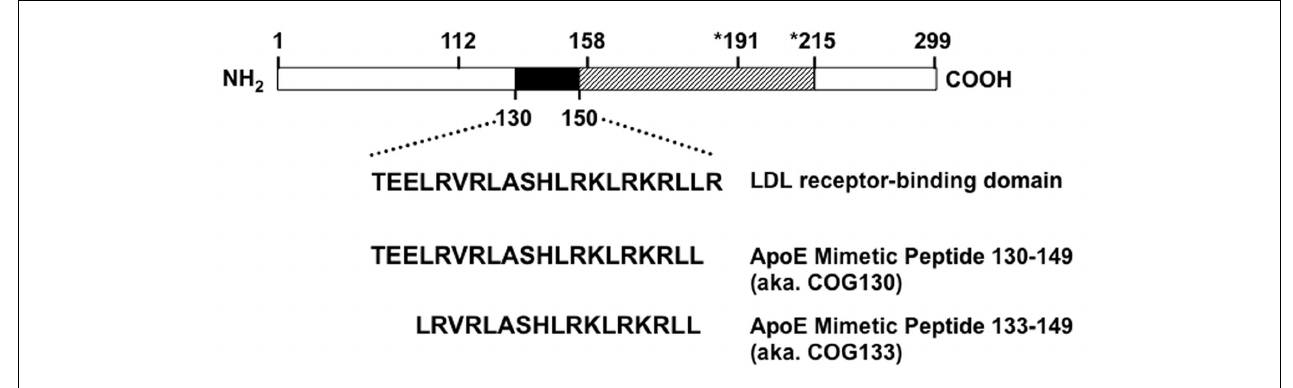
of the lipid-binding domain at position 215.The amino-terminal portion through residues 1–191 forms a 4-helix anti-parallel bundle followed by a hinge region that extends to residue 215.The carboxy terminal region from 215 to 299 defines the largely unstructured lipid-binding domain with a major lipid-binding region from residues 244 to 272.The apoE-mimetic peptide spanning residues 130–149 is also known as COG130, while the peptide spanning residues 133–149 is also known as